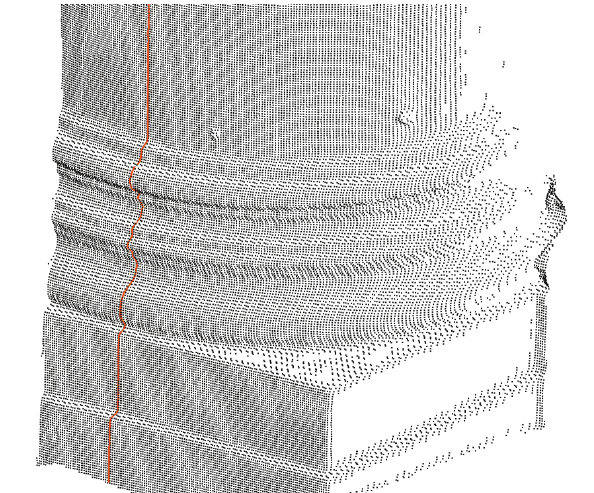
Figure 8. The San Carlo column base. Detail of range based model with extraction of